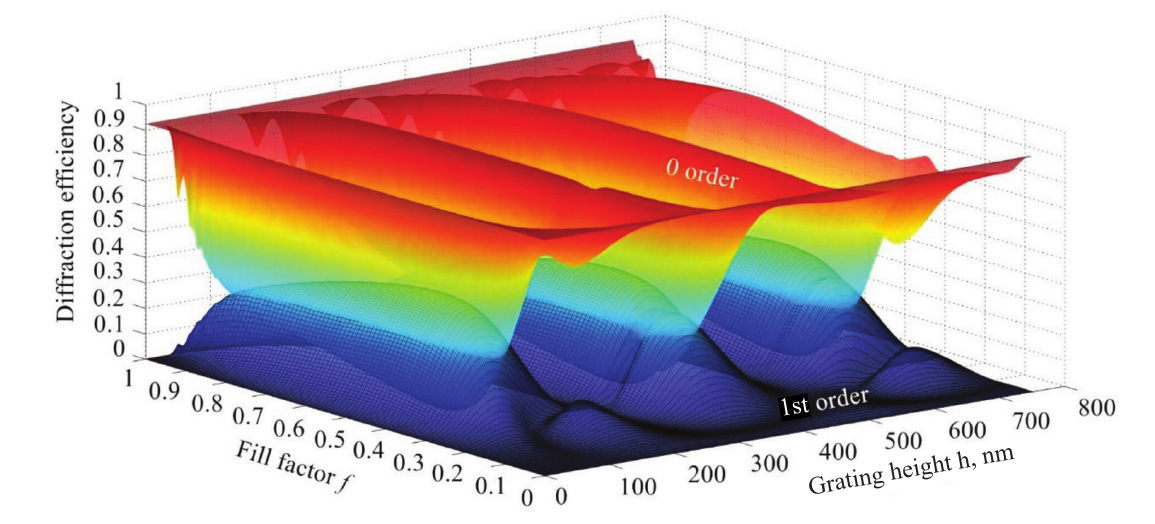
Fig. 3. Diffraction efficiencies of the first and the zero order under TM condition as a function of ridge height h (0‒d) and fill factor f (0‒1) for aluminium rectangular gratings (d = 752